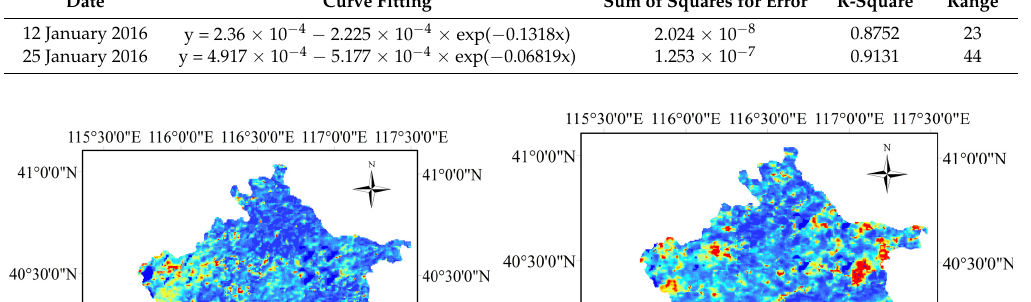
Figure 12. Comparison between inversion AOD and MOD 04 AOD. The black dots represent 50 sets geographical location, and the red solid line represents y = x. Table 7. Validation of inversion AOD and MOD_04 AOD. Sample Number Average Absolute Error Average Relative Error 50 0.055